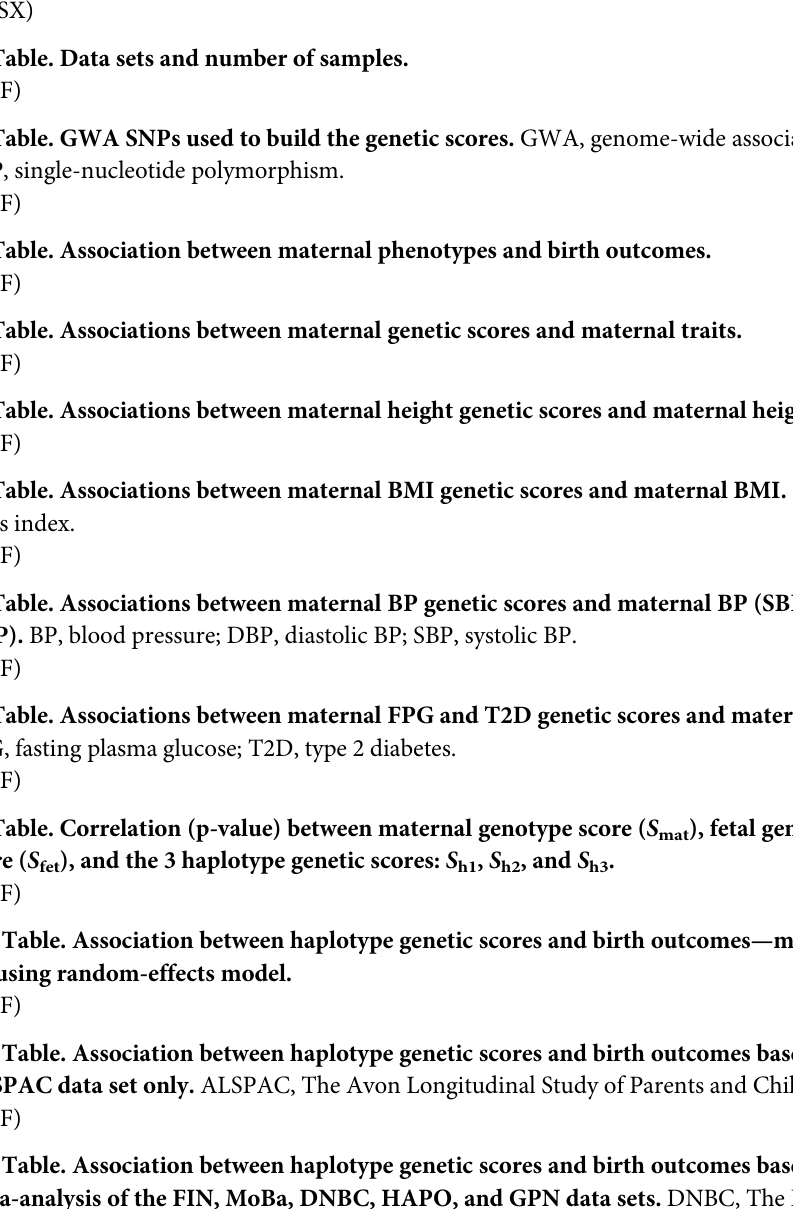
S10 Table. Association between haplotype genetic scores and birth outcomes—meta-analy- ses using random-effects model. S11 Table. Association between haplotype genetic scores and birth outcomes based on the ALSPAC data set only. ALSPAC, The Avon Longitudinal Study of Parents and Children. S12 Table. Association between haplotype genetic scores and birth outcomes based on meta-analysis of the FIN, MoBa, DNBC, HAPO, and GPN data sets. DNBC, The Danish National Birth Cohort; FIN, The Finnish birth data set; GPN, The Genomic and Proteomic Network for Preterm Birth Research; HAPO, Hyperglycemia and Adverse